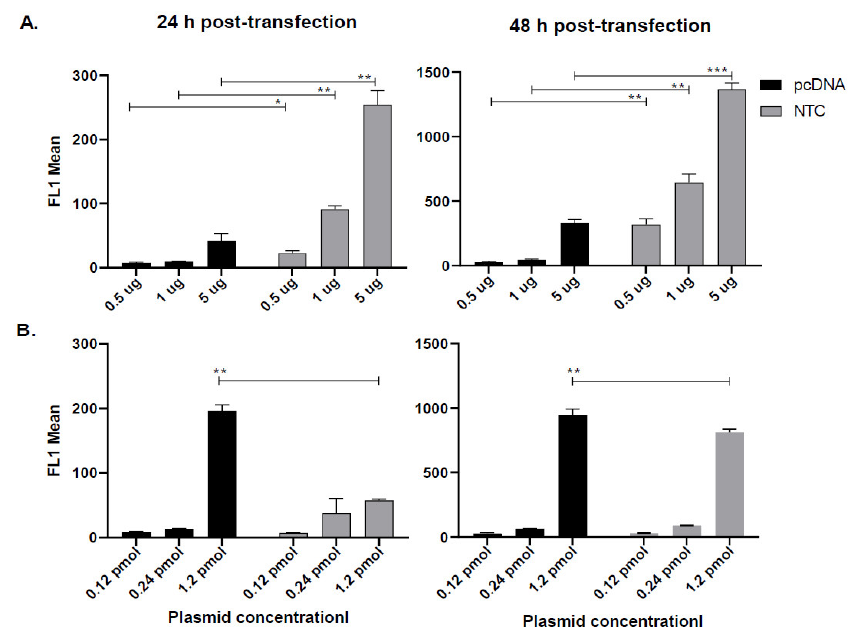
Figure 2. MFI evaluated by flow cytometry. COS-7 cells were transfected with equal concentration ( A ) or equimolar concentrations ( B ) of pcDNA-EGFp or NTC-EGFP. 24 h (left graphs) and 48 h (right graphs) later, cells were harvested and MFI was analyzed by flow cytometry in FL1 channel. A total of 10,000 events were acquired by the Partec instrument. The results are representative of two separate experiments and error bars indicate the within-assay repeats in each experiment. Data were compared using Student’s t-test. * p < 0.05, ** p < 0.01, *** p < 0.001.